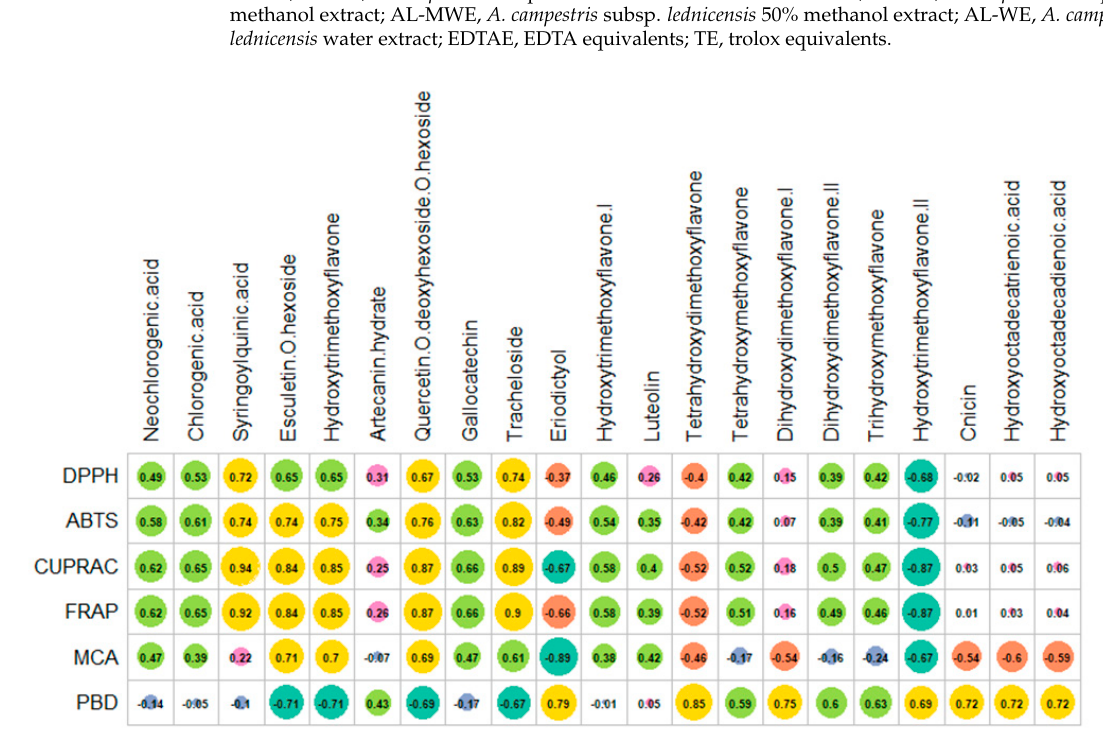
Figure 4. Pearson correlation between the antioxidant activity and individual phytochemicals.